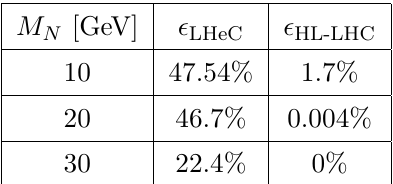
Table 2 . A comparison of signal cut efficiencies between the proposed displaced fat jet search at the LHeC and the multi-track displaced vertex search at the HL-LHC.